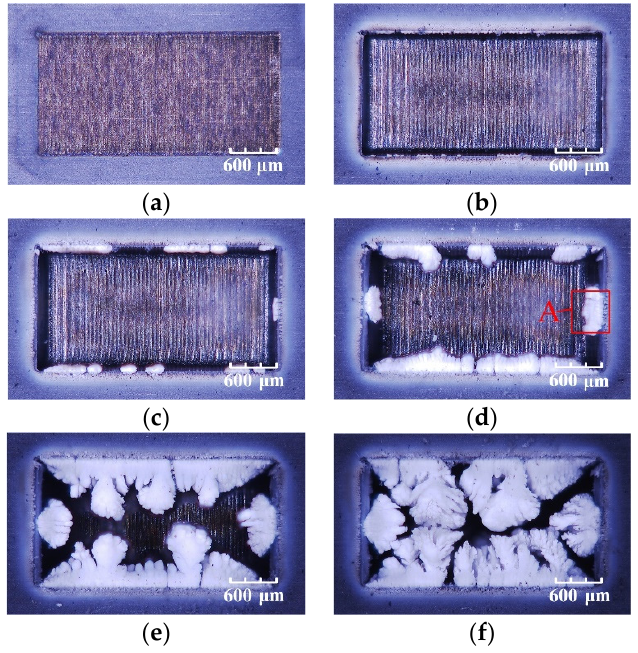
Figure 3. Workpiece morphology processed a different number of times by conventional laser processing prior to cleaning: ( a ) 1 time, ( b ) 50 times, ( c ) 100 times, ( d ) 200 times, ( e ) 300 times, ( f ) 400 times.